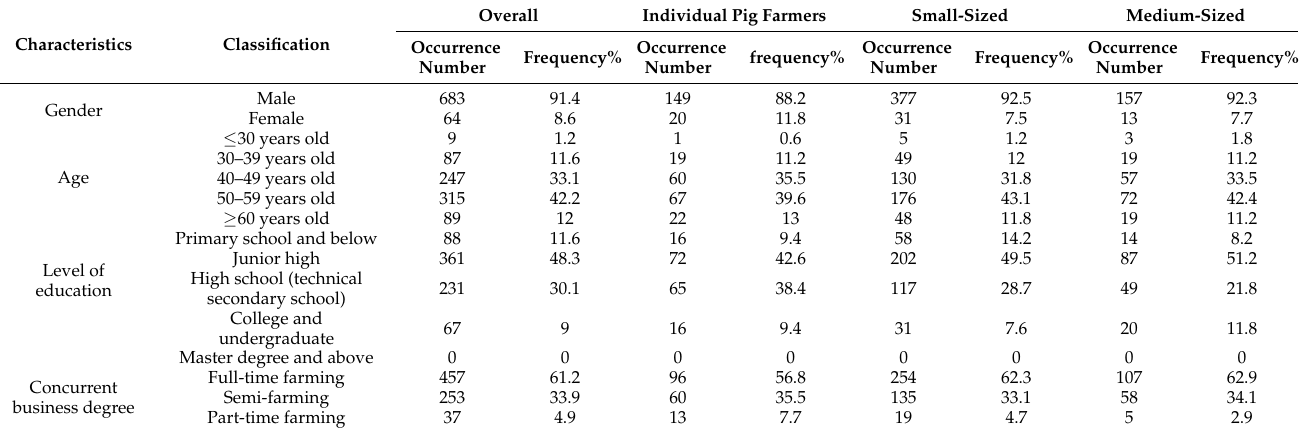
Table 3. Table 3. Description of Sample